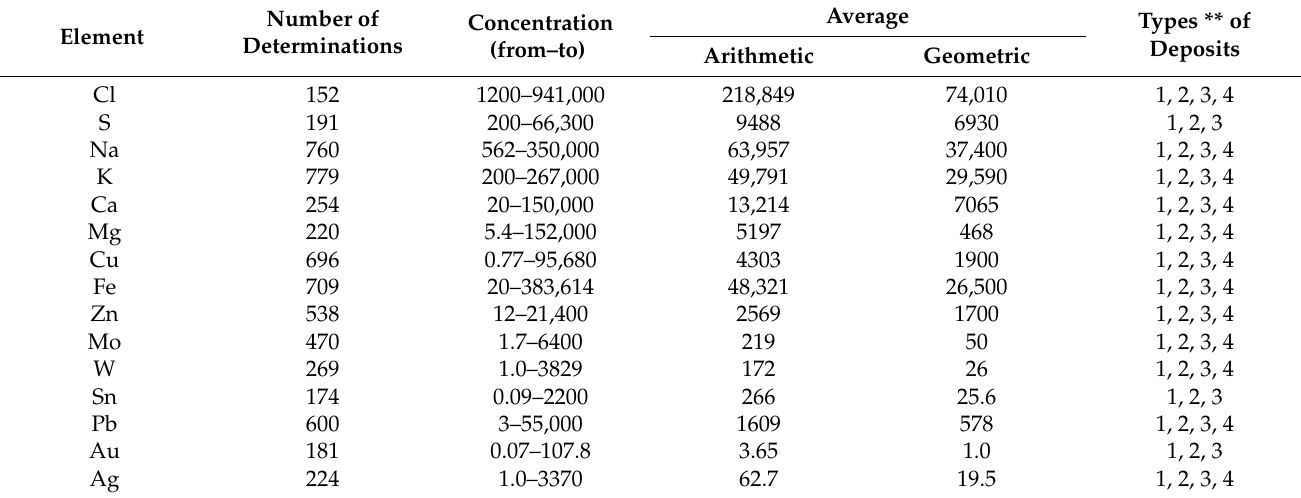
Table 4. Concentrations (ppm) of some elements in mineralizing fluids at porphyry deposits